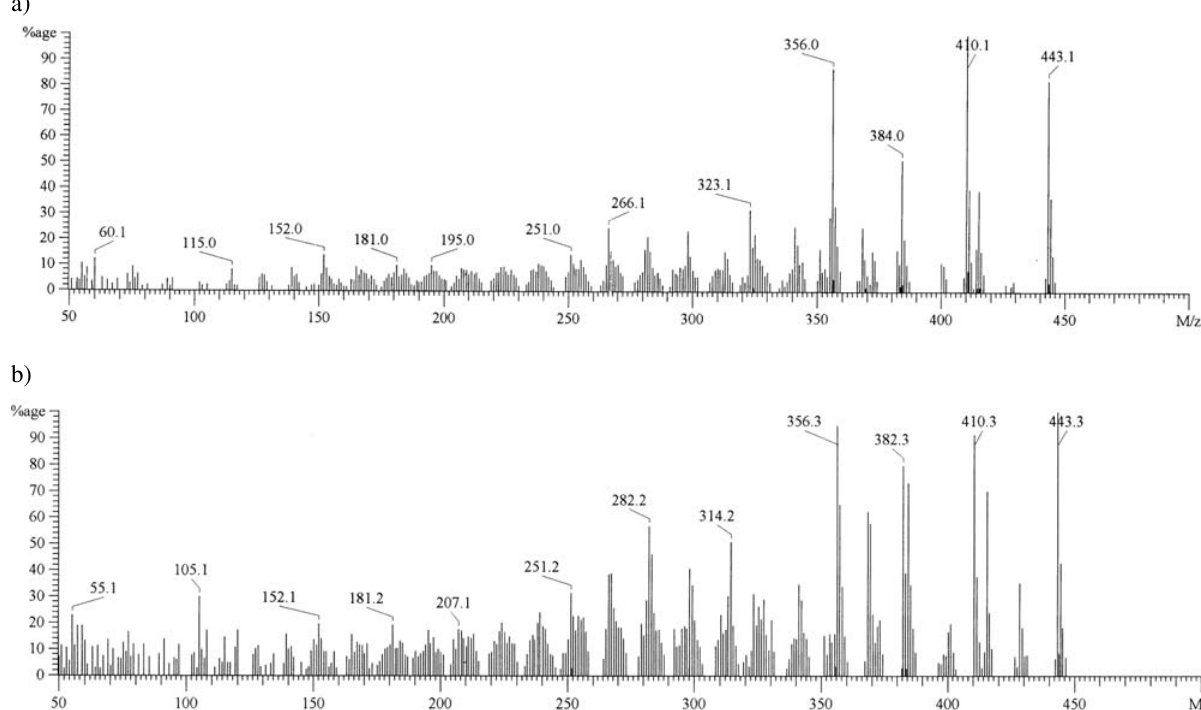
Fig. 2. The EI mass spectra of 10-thio-propylcolchicines a) n -propyl isomer 3 b) iso -propyl isomer